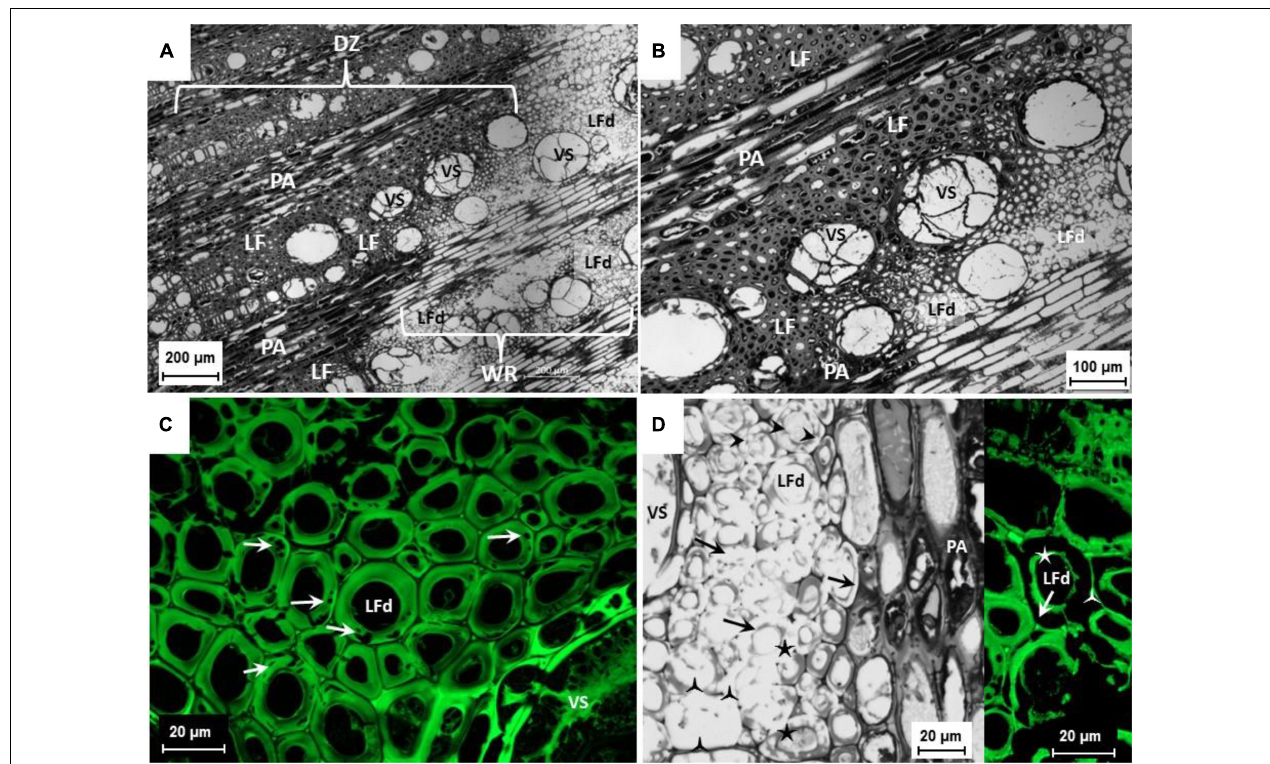
FIGURE 2 | (A,B) Cross section of a symptomatic cv. Sauvignon blanc trunk. Lesion affected by white rot, vessels (VS) obstructed by tylosis; demarcation zone (DZ) identifiable by dark inclusions in the libriform fibers (LF) and parenchymal cells (PA) of the pith rays; white rot (WR) with decomposed libriform fibers (LFd). Bright-field Plan-Neofluar 5x (A) and bright-field Plan-Apochromat 10x (B) . (C) Cross section of a symptomatic cv. Sauvignon Blanc trunk. Lesion affected by white rot, vessels (VS) obstructed by tylosis; libriform fibers (LFd) with beginning of cell wall decomposition, S2 layer of the secondary cell wall with cavities caused by Fmed (arrows). Epi-FM image, excitation 460-488 nm, emission 500-557 nm; C-Apochromat 63x. (D) Cross section of a symptomatic cv. Riesling trunk. Lesion affected by white rot, vessels (VS) obstructed by tylosis; libriform fibers (LFd) with beginning of the cell wall decomposition, S2 layer of the secondary cell wall with cavities caused by Fmed (arrow heads) and advanced decomposition of the S2 layer (arrows), only middle lamella with primary cell wall and S1 layer ( ) as well the S3 layer ( (cid:72) ) of the secondary cell remained. Bright field, C-Apochromat 40x. On the right extract, libriform fibers (LFd) with advanced cell wall decomposition, S2 layer of the secondary cell wall totally decomposed, only middle lamella with primary cell wall and S1-layer ( ) as well the S3 layer ( (cid:72) ) of the secondary cell remained.